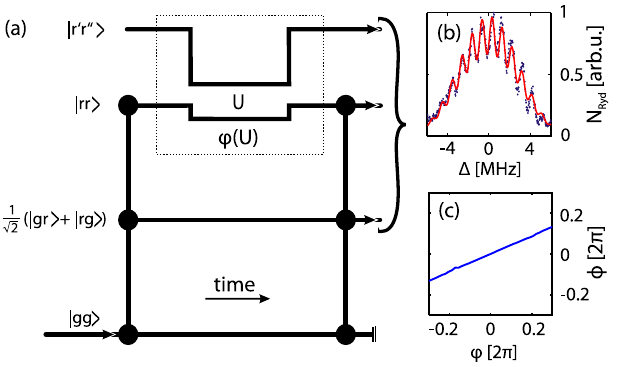
FIG. 2. (a) Stark map of the relevant pair states (see text). (b) A magnification of the Stark map at the electric fields where the pair states are tuned into resonance. The dotted lines denote the pair-state energies without coupling; the solid lines include the dipole-dipole coupling for an interatomic distance of 9 (cid:3) m . The energy differences at the resonant electric field E and at a detuned electric field E det are